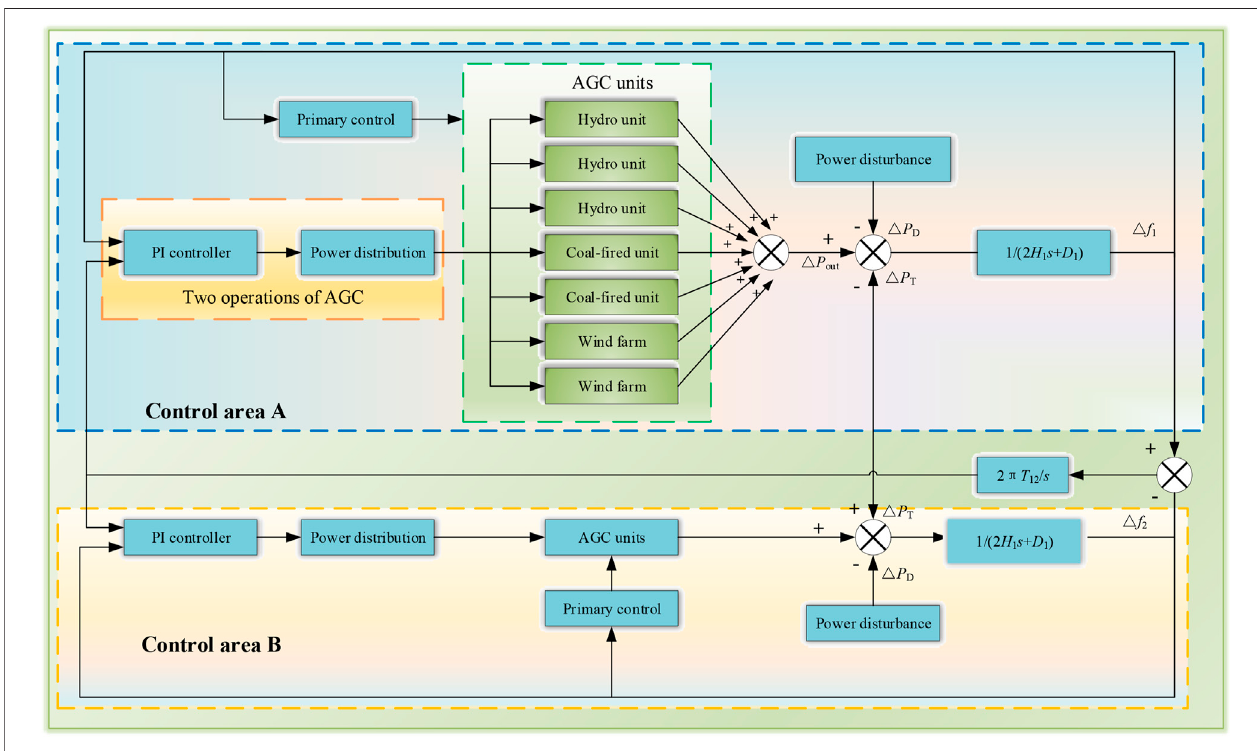
FIGURE 1 | AGC structure of the two-area LFC model.